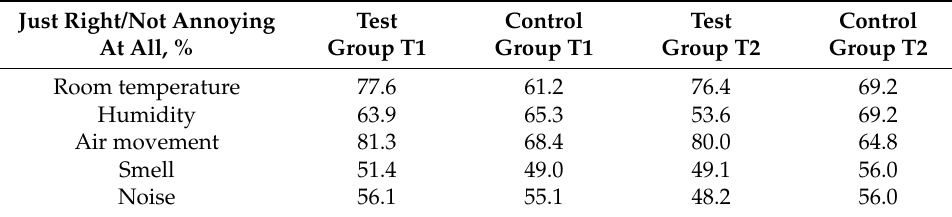
Table 6. Perception of indoor climate, smell and noise. Percentage of participants who answered with “just right” regarding room temperature, humidity, air movement or “not annoying at all” regarding smell and noise. T1 (three months after moving in) and T2 (one year